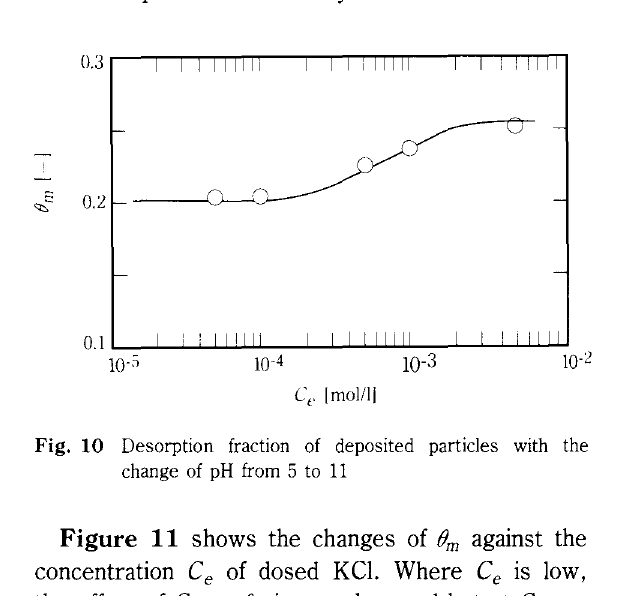
Fig. 10 Desorption fraction of deposited particles with the change of pH from 5 to 11